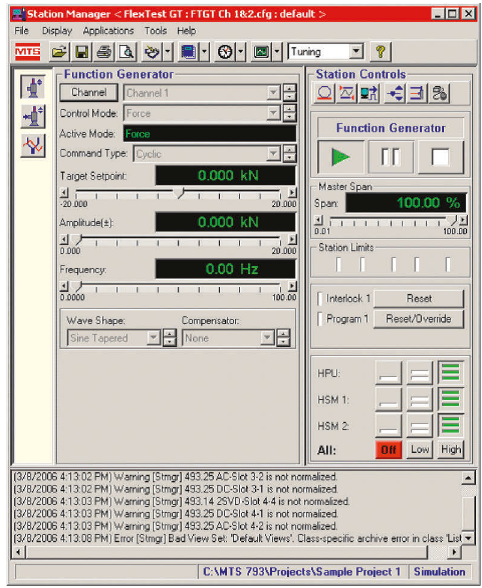
Figure 5: Interface of the station